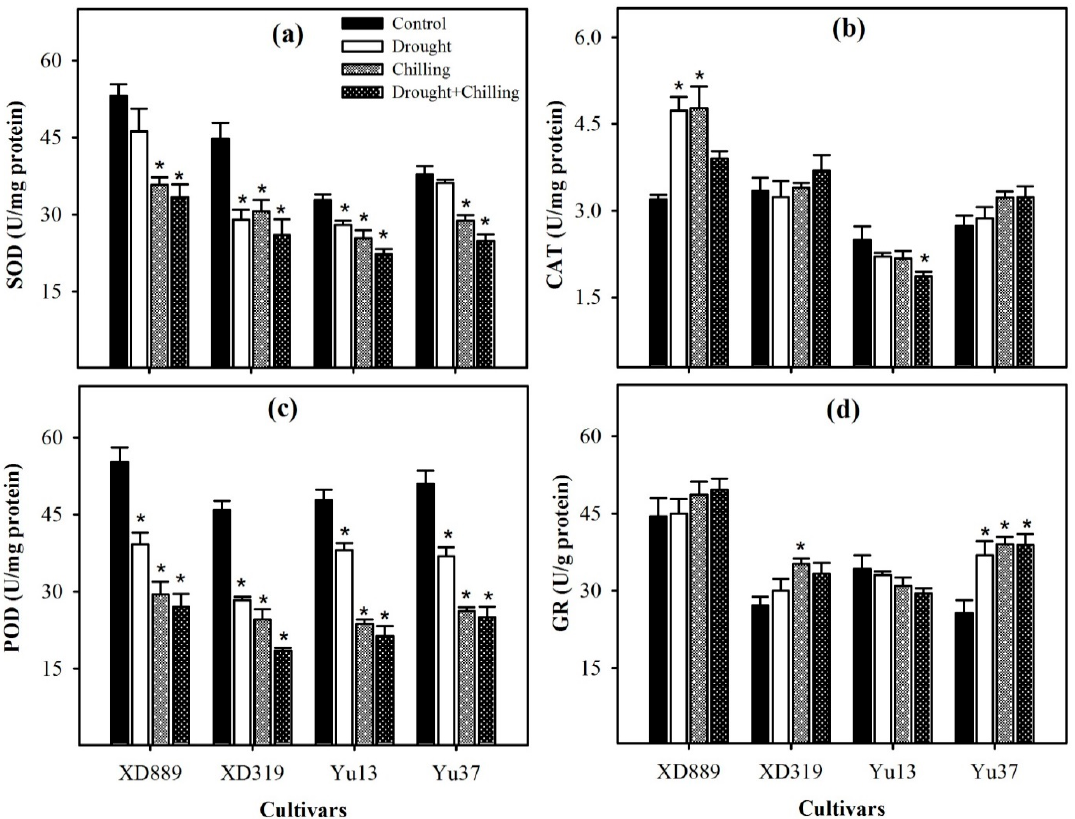
Figure 9. Activities of superoxide dismutase ( a ), catalase ( b ), peroxidase ( c ), and glutathione reductase ( d ) in the leaves of four maize cultivars as influenced by the drought, chilling, and drought + chilling stresses. Vertical bars above mean indicate standard error of three replicates. Mean value for each treatment with * indicate significant differences compared with control according to LSD test ( P ≤ 0.05).